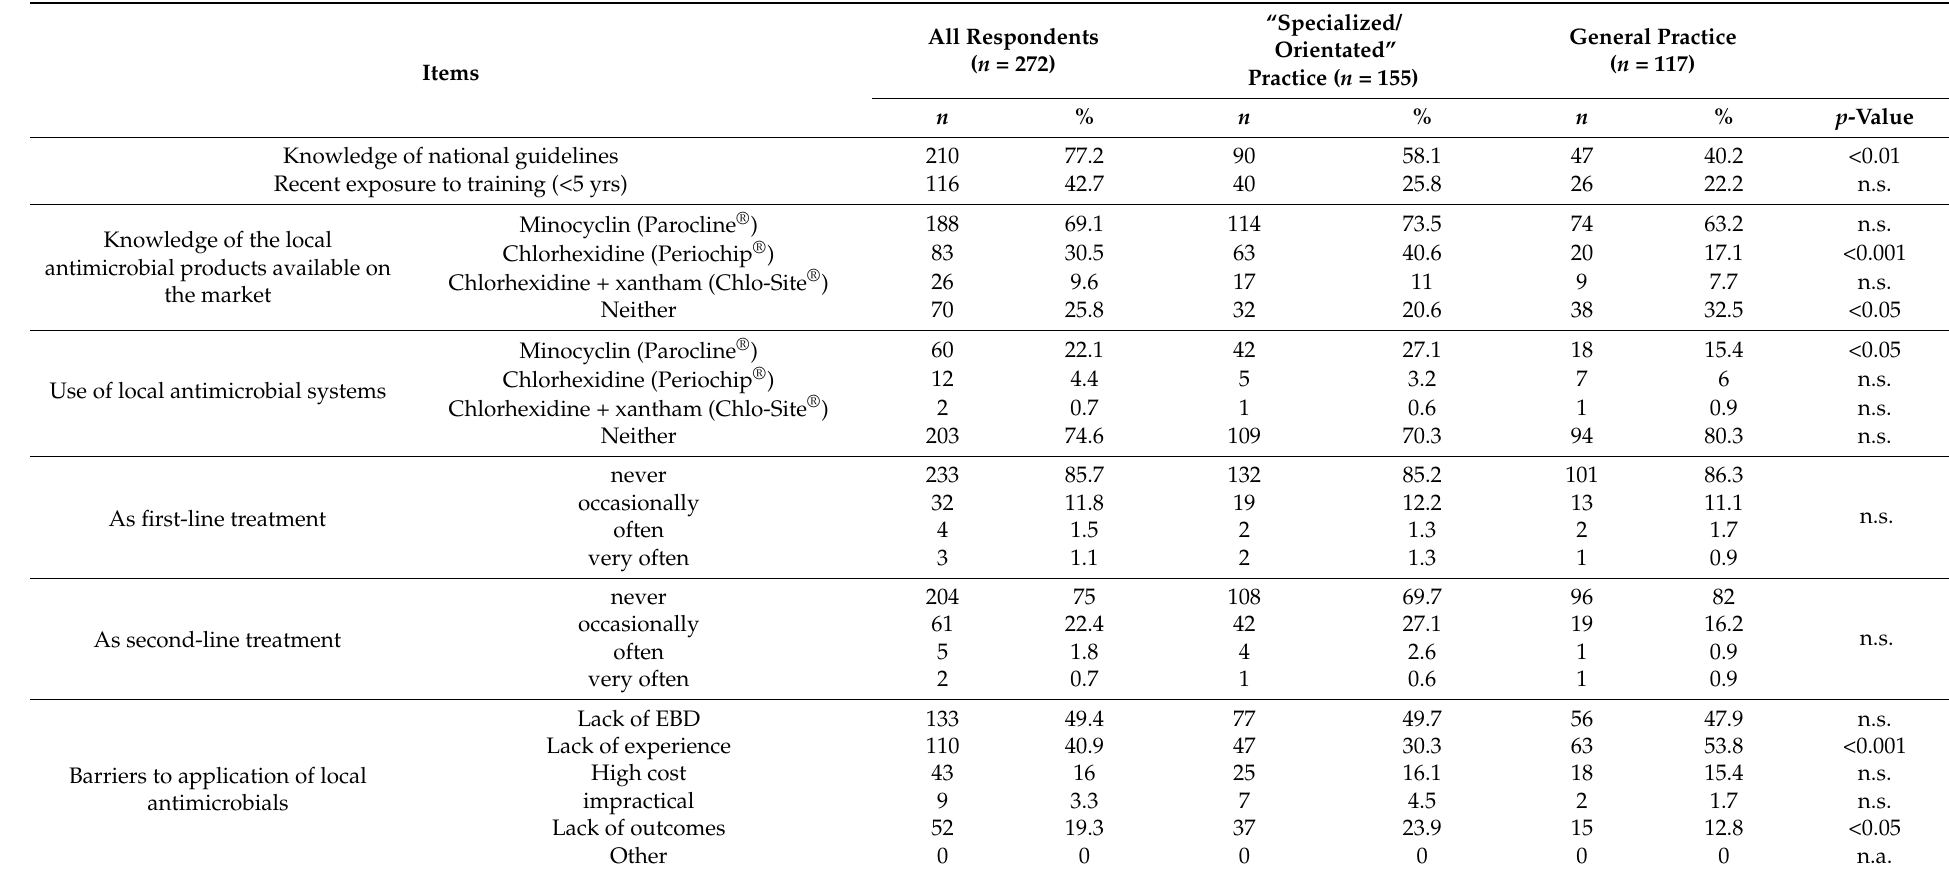
Table 2. Use of local antibiotics delivery systems by French